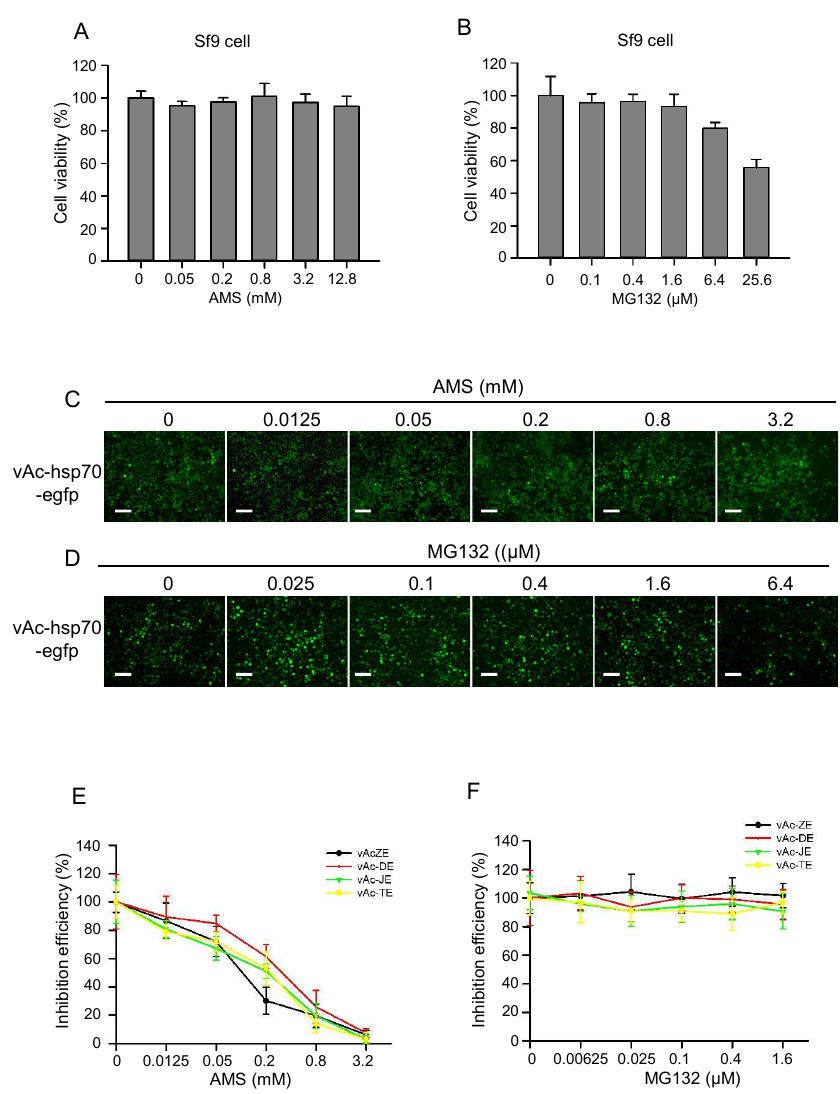
Figure 6. AMS but not MG132 effectively blocked baculovirus-expressed flavivirus E proteins induced syncytia. ( A ) AMS cytotoxicity was assessed by the viability of Sf9 cells treated with AMS. Pre-seeded Sf9 cells were treated with increasing concentrations of AMS for 24 h, and then subjected to cell viability analysis using CCK-8. ( B ) MG132 cytotoxicity was assessed by the viability of Sf9 treated with MG132. Pre-seeded Sf9 cells were treated with increasing concentrations of MG132 for 24 h, and then subjected to cell viability analysis using CCK-8. ( C ) The effect of AMS on the infectivity of baculovirus and expression of heterologous protein were evaluated using control baculovirus vAc-hsp70-egfp which expressed enhanced green fluorescent protein (egfp). ( D ) The effect of MG132 on the infectivity of baculovirus and expression of heterologous protein were evaluated using control baculovirus vAc-hsp70-egfp which expressed egfp. Bars, 100 µ m. ( E ) AMS effectively blocked baculovirus-expressed flavivirus E proteins induced syncytia. ( F ) MG132 had no effect on baculovirus-expressed flavivirus E proteins induced syncytia. The number of syncytia within a field of view was counted for statistical analysis. The means and SD correspond to data collected from five random fields of